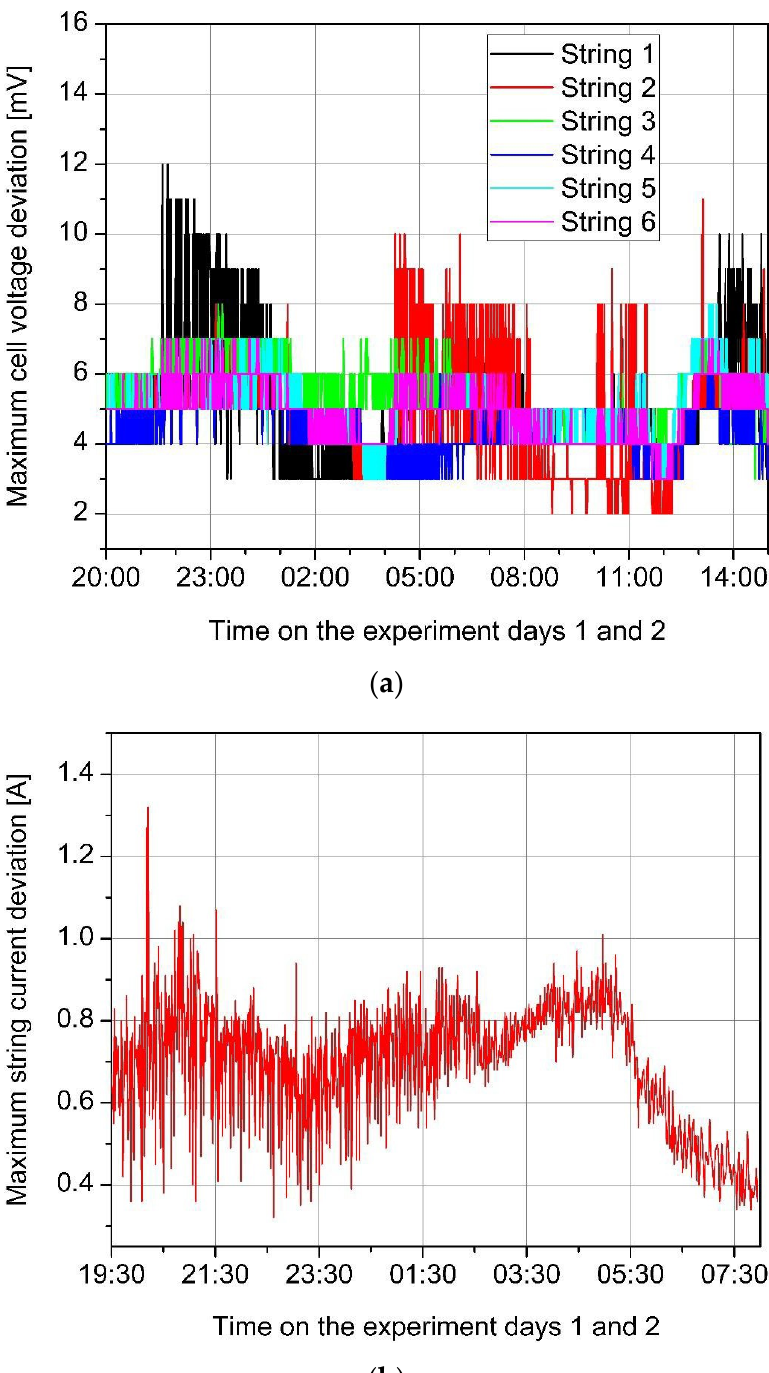
Figure A3. Maximum cell voltage deviation and string current deviation during the discharging and charging experiment presented in Section 5: ( a ) The differences of single cell voltages in a serial connection within the individual strings, which should be monitored in a second-life lithium ion battery operation in order to indicate possible mismatches due to progressive aging, are plotted in a selected time period; ( b ) the same applies to the di ff erences of string currents within the six parallel connections of the module configuration.